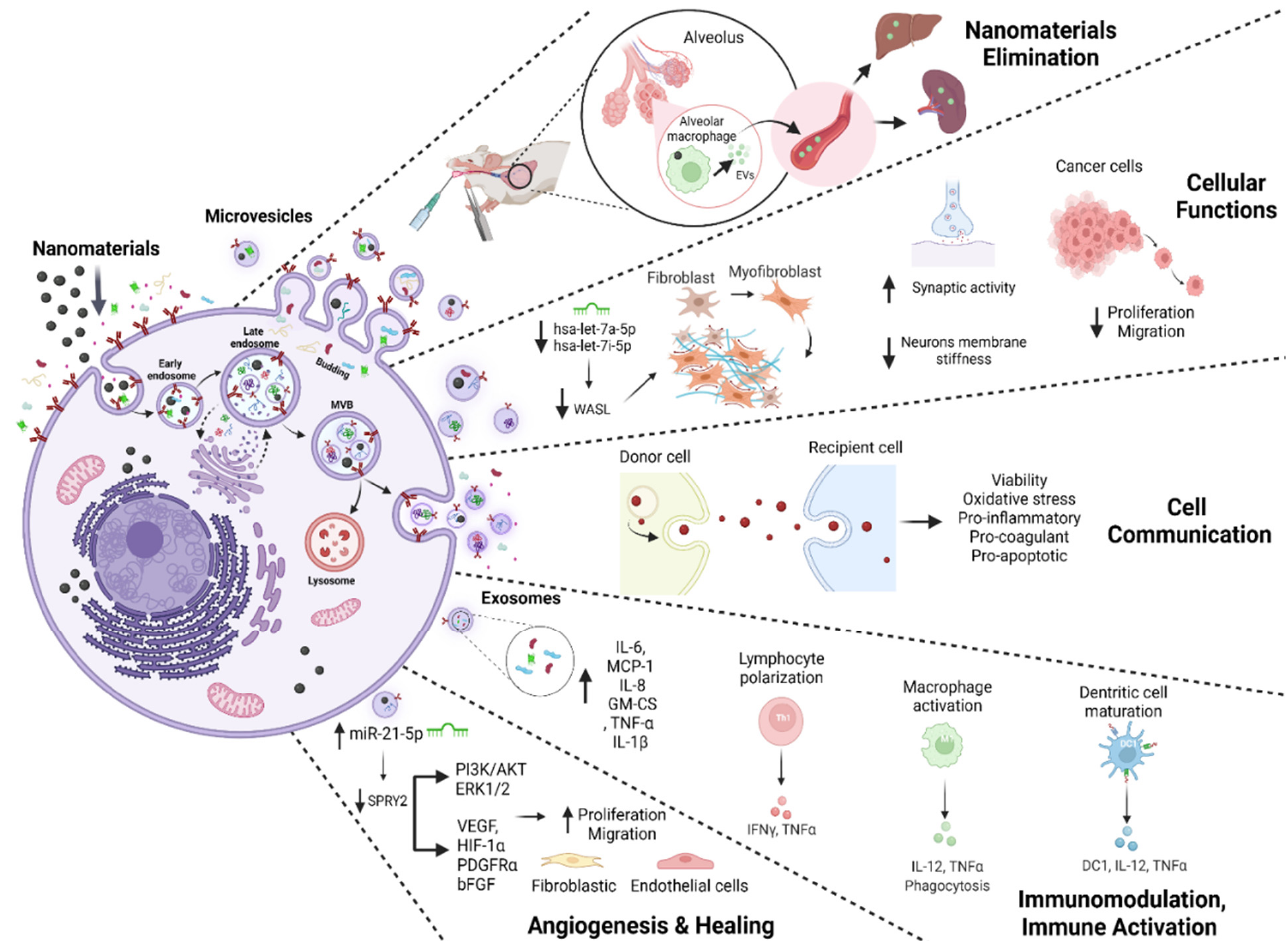
Figure 4. Cell exposure to NMs induces EV biogenesis and modulations in various biological activities: elimination of NMs; impact on cellular functions; alterations in cell communication; immunomodulation, inflammation, and immune activation; and angiogenesis and healing.